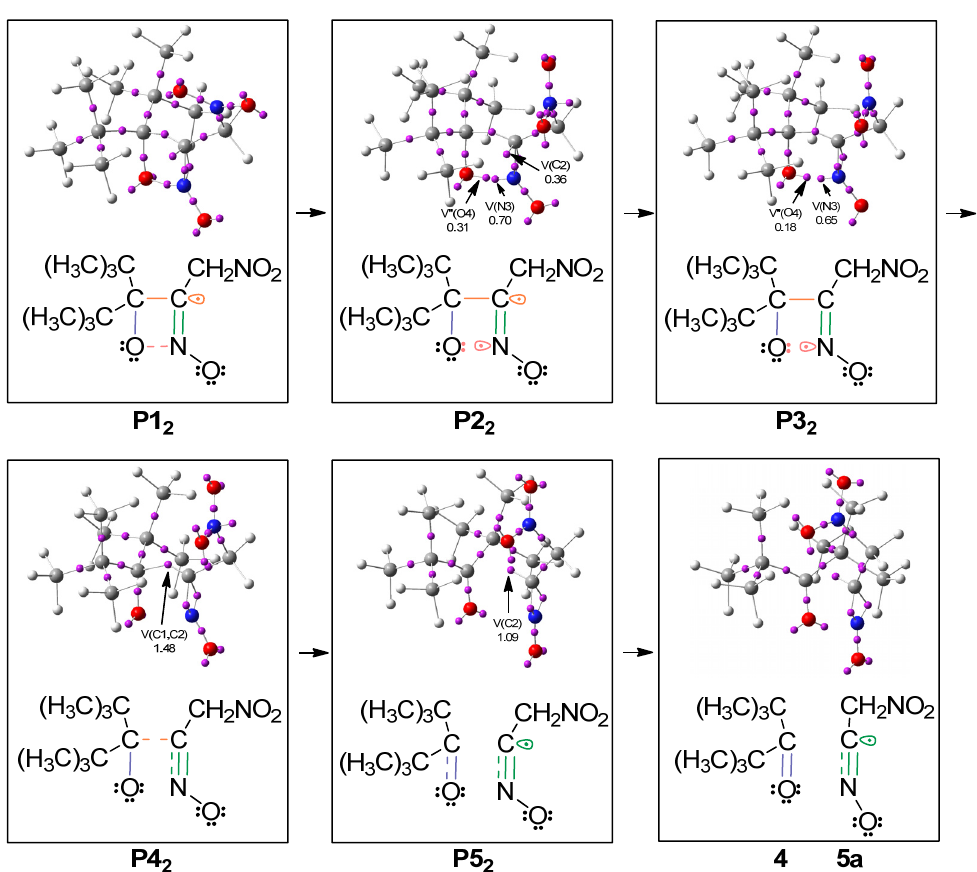
Figure 5. Attractor positions of the most important ELF valence basins of the IRC structures P1 2– 4 + 5a together with simplified representation of the molecular mechanism by Lewis-like structures arising from the topological analysis of the ELF along the reaction path for the retro-32CA of the 4,4-di-tert-butyl-3-nitromethyl-4H-[1,2]oxazete 2-oxide ( 3a ) leading to di-tert-butyl ketone ( 4 ) and nitrile oxide derivative ( 5a ). Figure shows the most important ELF valence basin populations to illustrate which populations disappear and which form in the individual phase. The electron populations, in average number of electrons, is given in